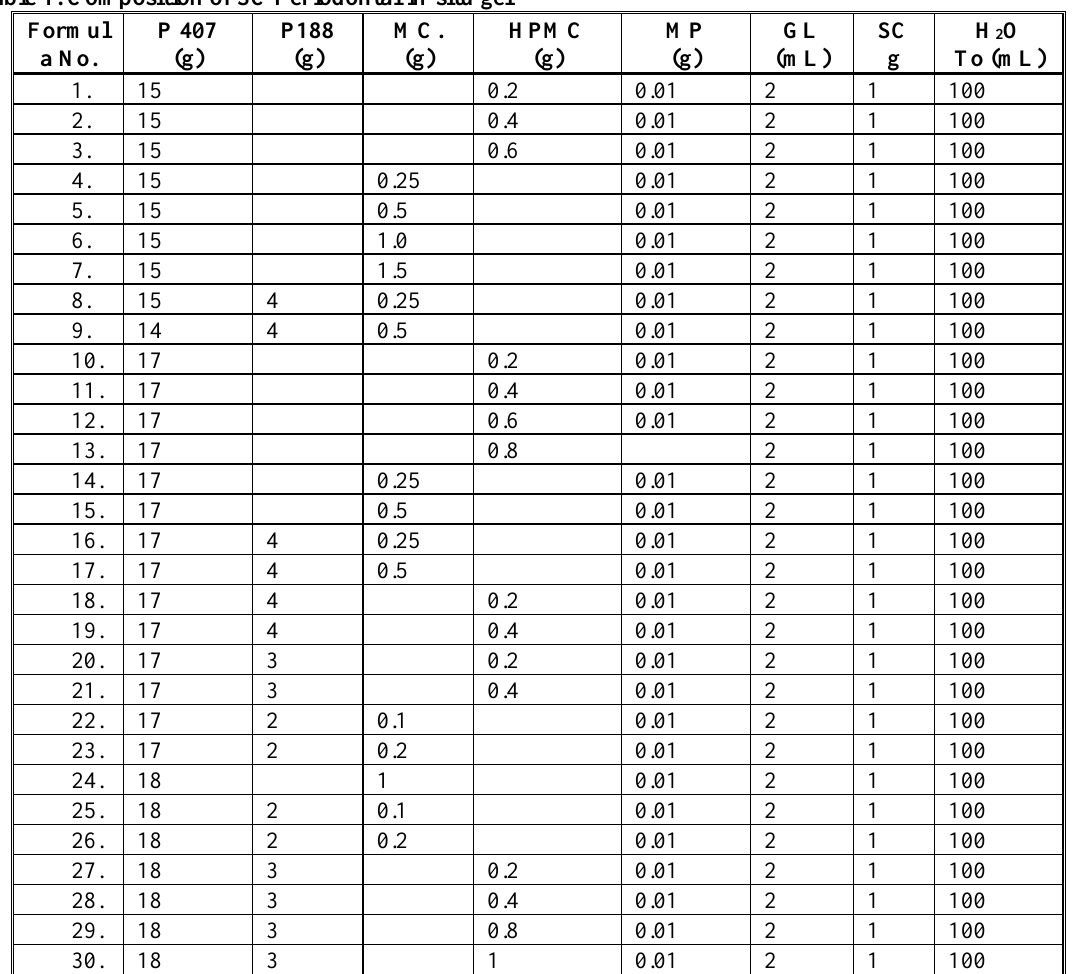
Table 1. Composition of SC Periodontal in-situ